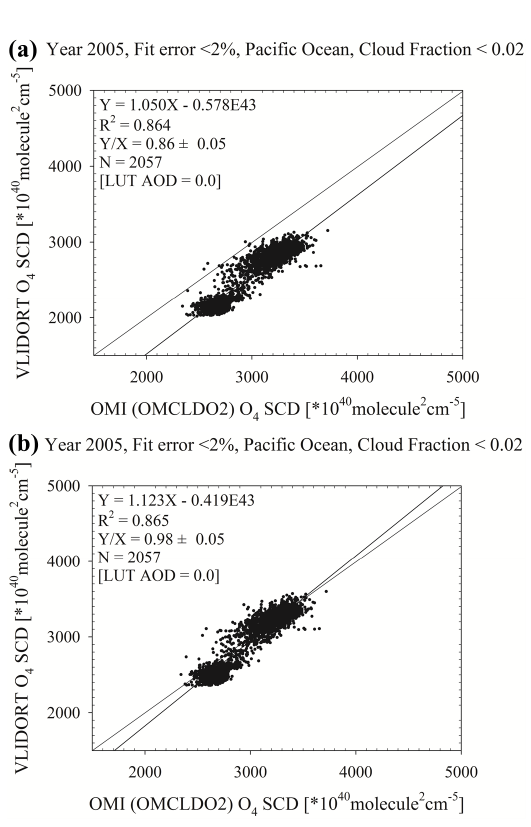
Figure 3. Comparison of the O 4 SCD at 477nm between the OMI standard product and the calculated value from LUT (a) before and (b) after correction of